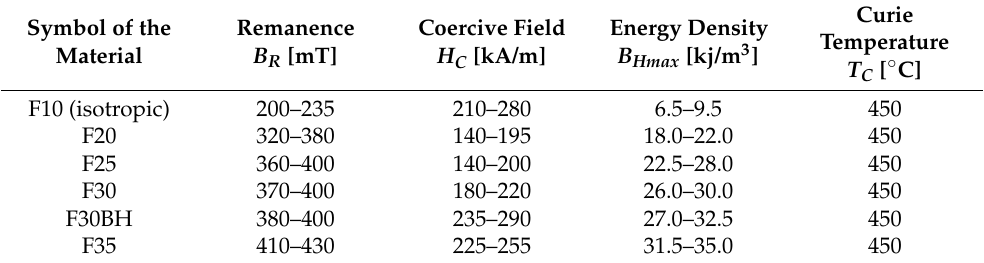
Table 1. Selected parameters of ferrite magnets